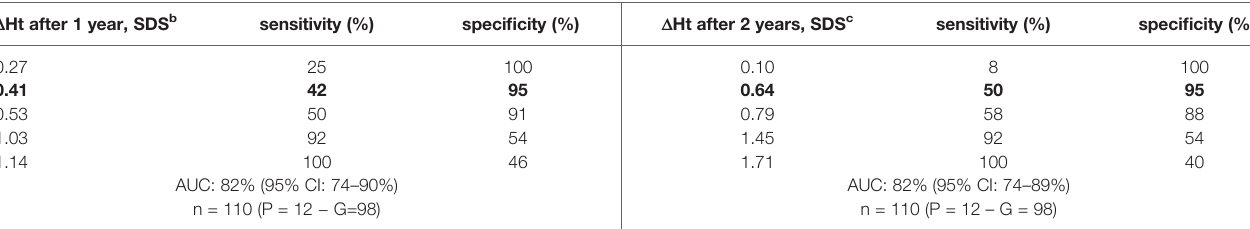
TABLE 4B | ROC curve analysis: cut-off values for D Ht SDS after 1 and 2 years of prepubertal GH treatment, with its sensitivity and speci fi city to predict total D Ht SDS <1 (CA). D Ht after 1 year, SDS